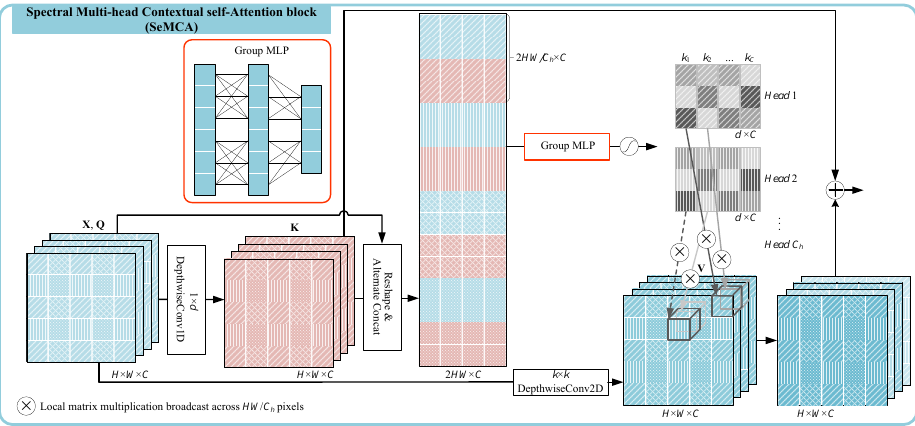
(b) SeMCA Figure 4. Architecture of the spectral multi-head contextual self-attention (SeMCA). The integrated DMuCA can alternate any standard convolution filter. For HSI classi- fication, we replace some convolutional layers in a ResNet backbone with our proposed DMuCA module, to strengthen the model with spectral-spatial contextual interdepen- dencies and attention perception. As illustrated in Figure 2, the backbone contains two residual blocks, and one of the convolution layers in each block is replaced by a DMuCA module. All of the other convolution layers are followed by batch normalization and ReLU activation layer. A global average pooling (GAP) and FC layer are performed to integrate the global spatial information and to project the learned feature into label space for probability prediction of classification. Table 1 shows the detailed model structure of the DMuCA network, taking the IN dataset as an example. Table 1. The detailed construction of our DMuCA network, a case on IN dataset. Layer/Block Kernel Type Kernel Size Input Sizes Output